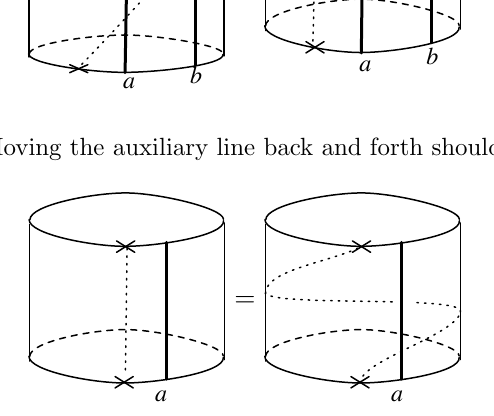
Figure 38 . Winding the auxiliary line all the way around, represented by X a; 1 , should not do